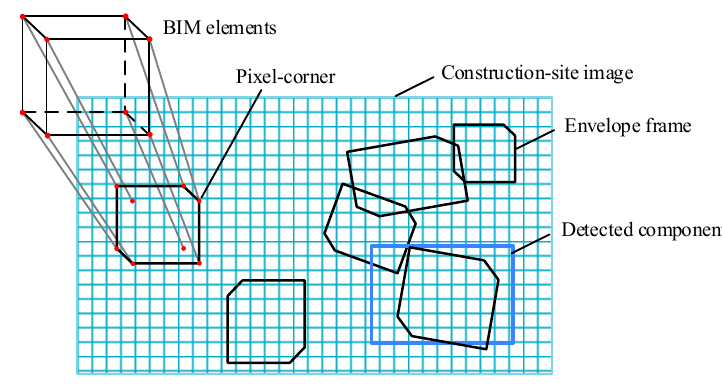
Figure 4. Envelope frame.